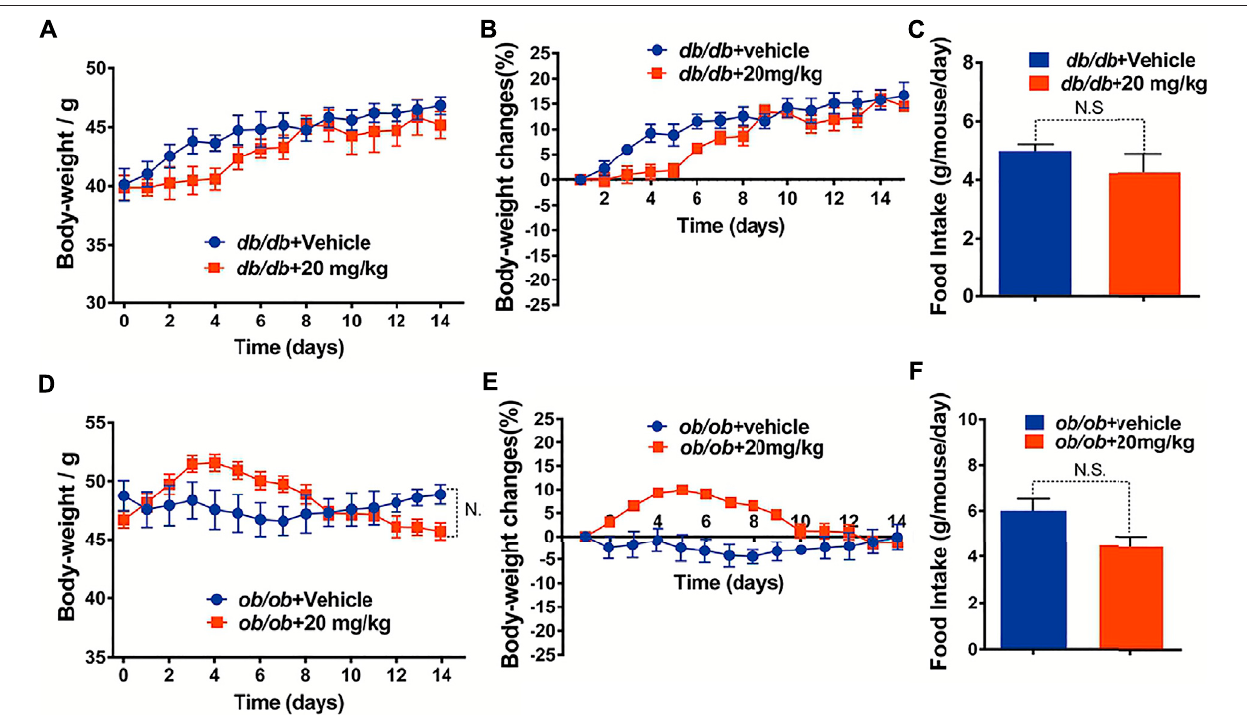
FIGURE6| GA-02re-activatesleptinsignaling.LeanmiceweretreatedwithvehicleorGA-02(20 mg/kg;i.p.)( n (cid:2) 8foreachgroup)for2 days,andeachgroupwas divided into two subgroups, and administered either saline or leptin (1 mg/kg; n (cid:2) 4 for each group; i.p.). (A) The average daily food intake and (B) body weight changes after 16 h of saline/leptin administration. DIO mice were treated with vehicle or GA-02 ( n (cid:2) 8 for each group; 20 mg/kg; i.p.) for 2 days, and each group was divided into twosubgroups,andadministeredeithersalineorleptin(1 mg/kg; n (cid:2) 4foreachgroup). (C) Theaveragedailyfoodintakeand (D) bodyweightchangesafter16 hof saline/leptin administration. Values are represented as mean ± SD. (* p < 0.05, ** p < 0.01, *** p < 0.001).